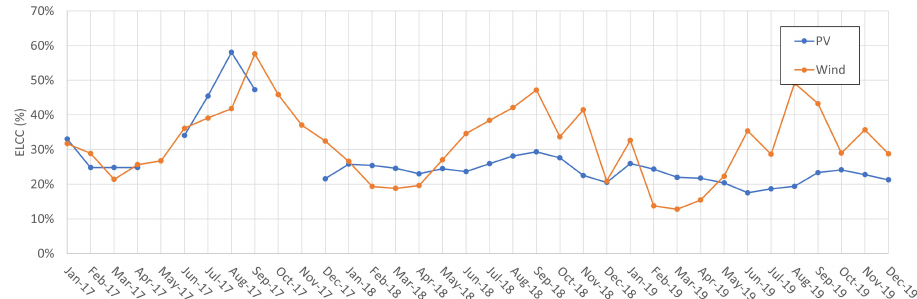
Figure 21. Monthly ELCC in percentages for the Northeast subsystem calculated based on the monthly installed capacity